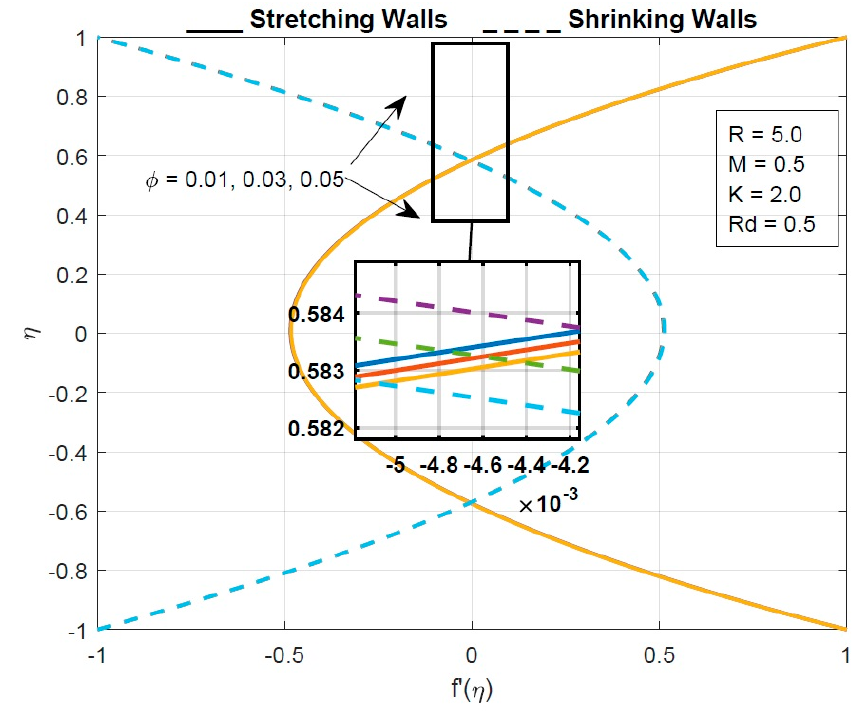
Figure 6. The effect of the solid volume fraction on the velocity profile.